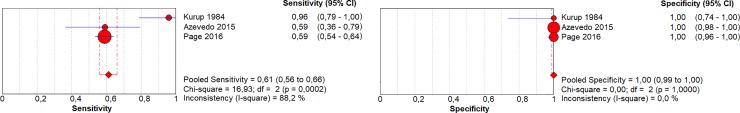
Forest plot of sensitivity (A), specificity (B), and heterogeneity from the DID and/or CIE test for the subgroup analyses (three studies with healthy controls).